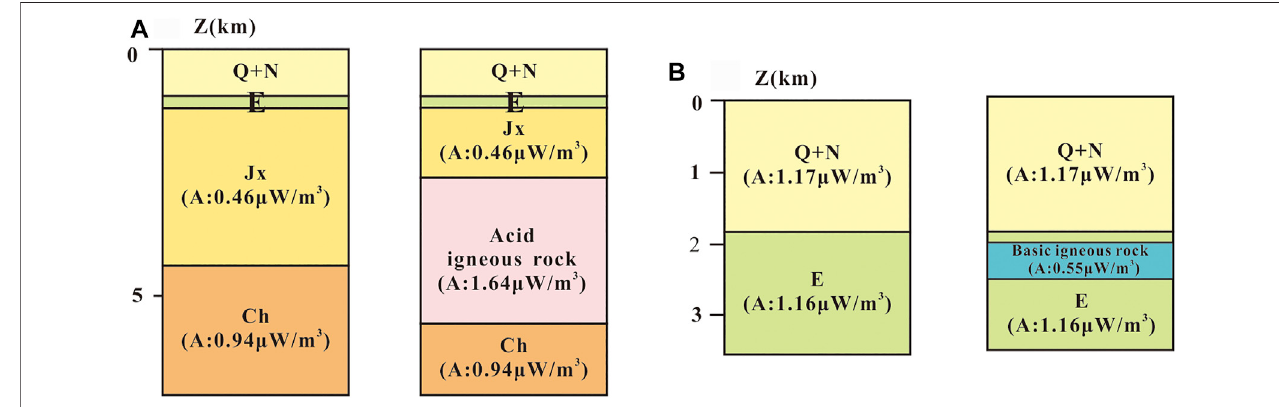
FIGURE 11 | Schematic diagram of heat production difference under the in fl uence of igneous facies, the heat production data was after by Cui et al. (2019). (A) Yanshanian intrusions; (B) Cenozoic intrusions.